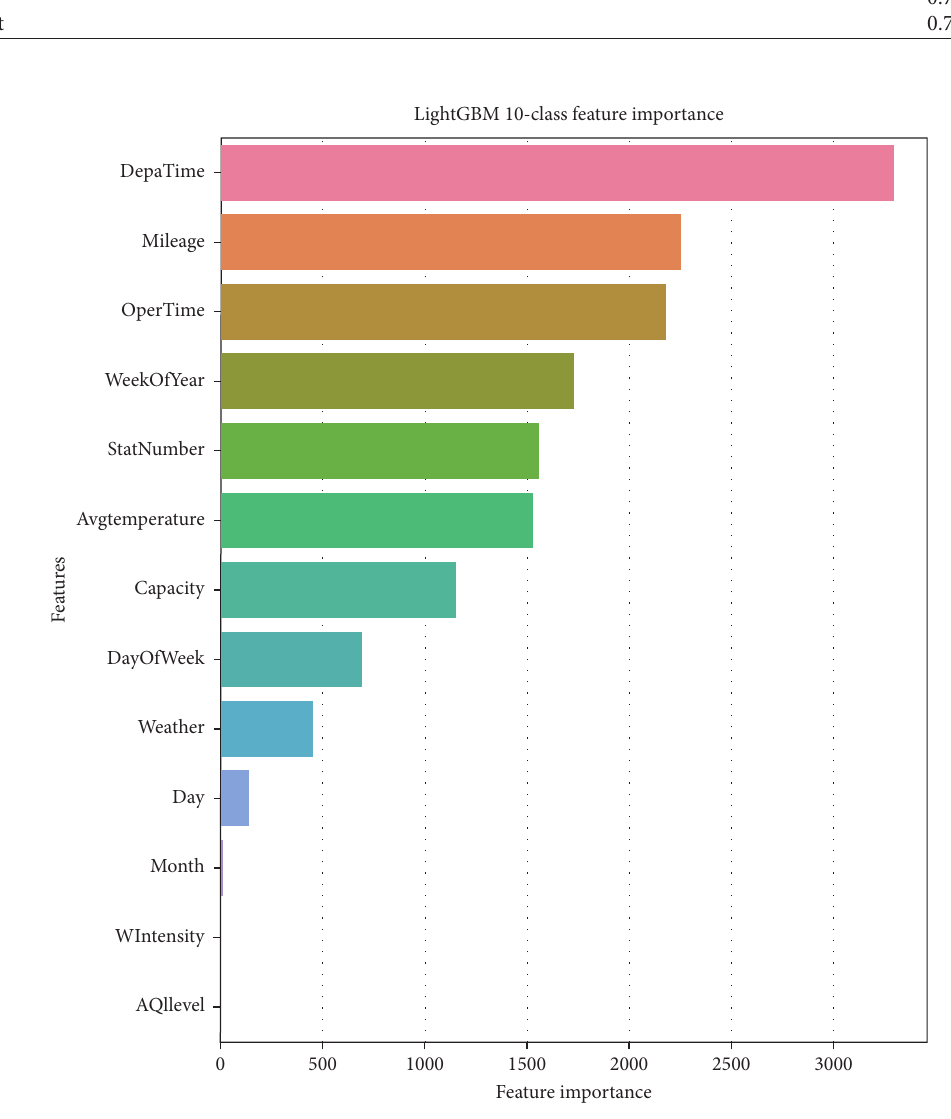
Figure 9: The importance of 10 classification model